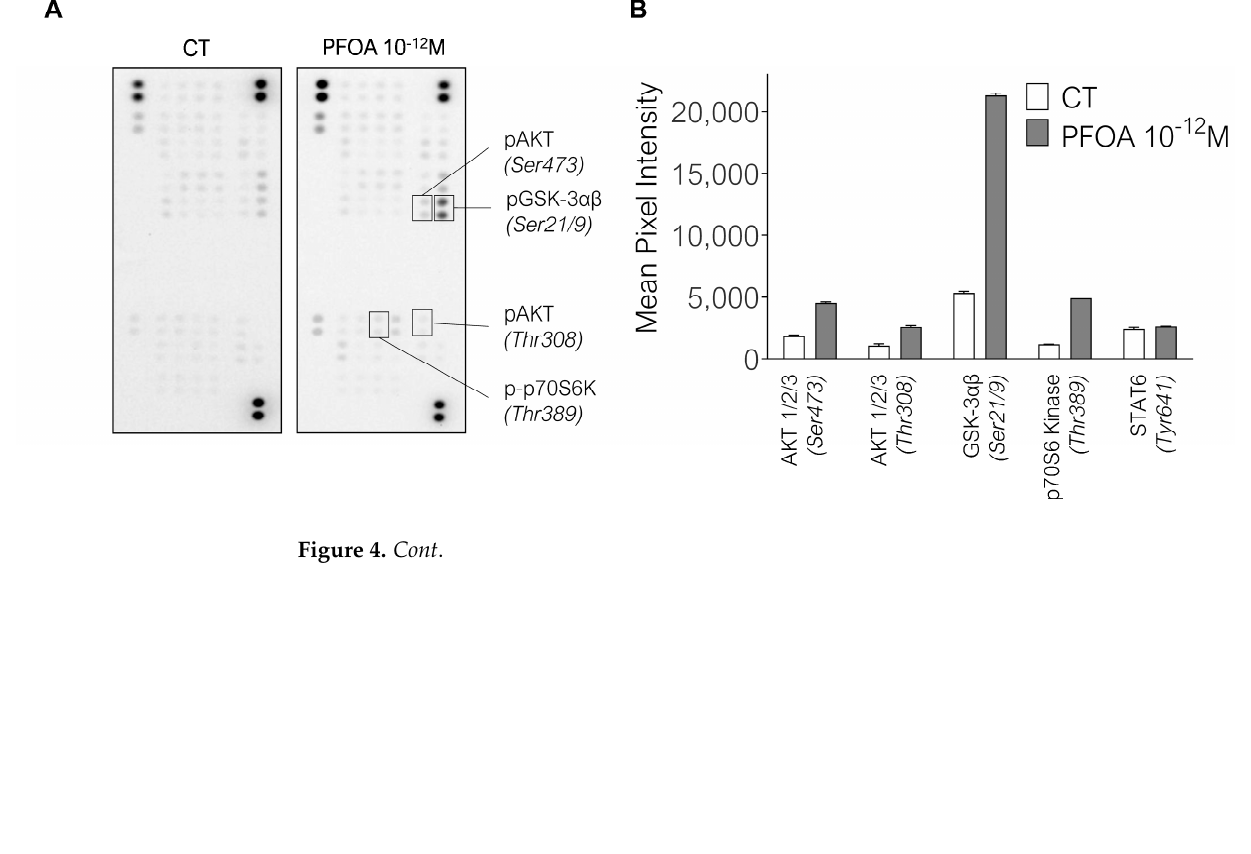
Figure 4. PFOA increases the phosphorylation of Akt and p70S6 kinase in MCF7 cells. ( A , B ) Image and quantification of Human Phospho-Kinase Array. Relative levels of protein phosphorylation of a range of 43 kinase phosphorylation sites of MCF7 cells after 48 h of treatment with PFOA (10 − 12 M) in comparison with cells exposed with EtOH (CT). ( C ) Western blot of phospho-AKT (Thr308 and Ser473), AKT total, phopsho-GSK3 αβ (Ser21/9), GSK3 αβ total, HSP90, phospho-p70S6Kinase (Thr389), p70S6Kinase total and actin of MCF7 cells protein extract after 48 h of treatment with PFOA (10 − 12 M) compared to cells treated with EtOH (CT). ( D ) Quantification of protein level of three independent western blot experiments. T test. * p < 0.05. To determine whether the pro-proliferative effect of PFOA was dependent on Akt or p70S6K phosphorylation, we treated MCF7 cells with rapamycin or LY294002, which are potent inhibitors of mTORC1 (an upstream kinase p70S6 kinase), and PI3K, respectively. Rapamycin decreased by 50% the phosphorylation of p70S6K (Figure 5A,C) and abolished